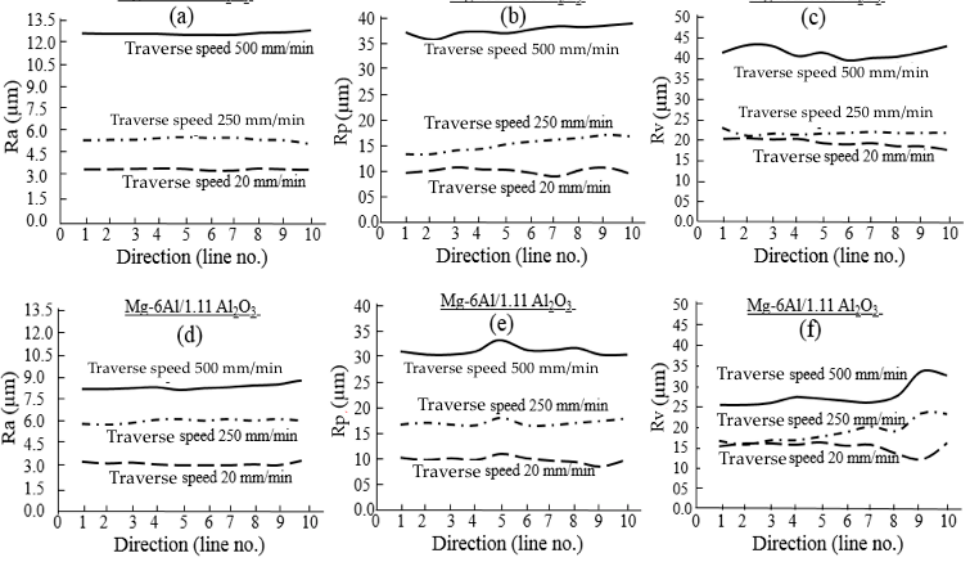
Figure 8. Effect of reinforcement content Mg-6Al/0.66 Al 2 O 3 ( a – c ), Mg-6Al/1.11 Al 2 O 3 ( d – f ) and traverse speed on surface roughness parameters Ra ( a , d ), Rp ( b , e ) and Rv ( c , f ) across the jet flow in different positions.